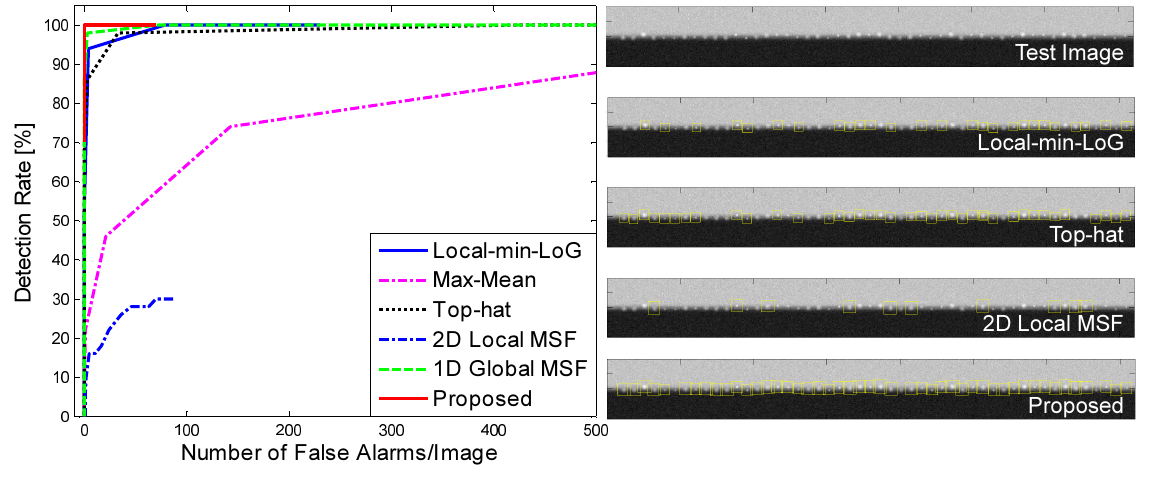
Figure 25. Processing time of the decision methods: CFAR vs. H-CFAR (adaptive hysteresis